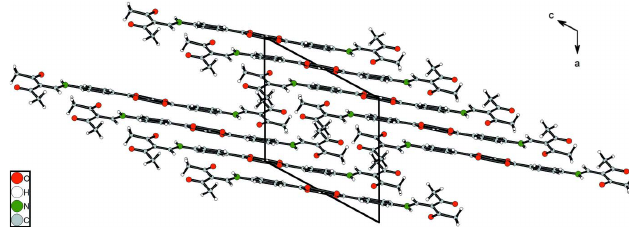
Figure 12 Molecular packing of 3 in the crystal in a view along the b